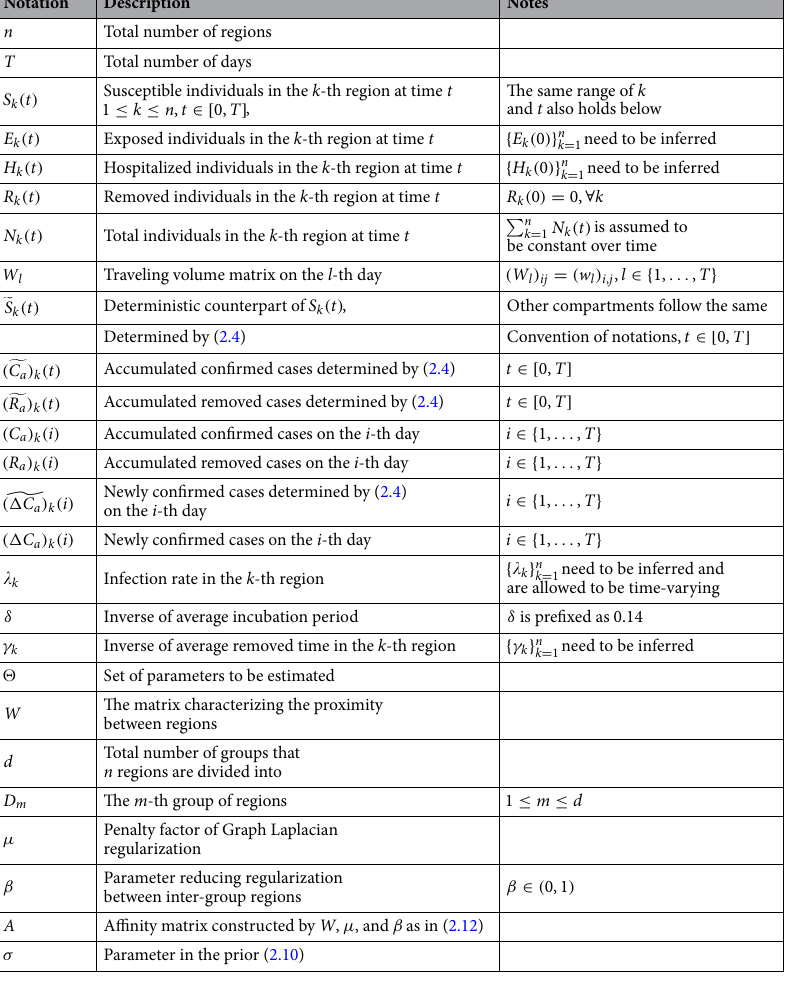
Table 1. List of notations and